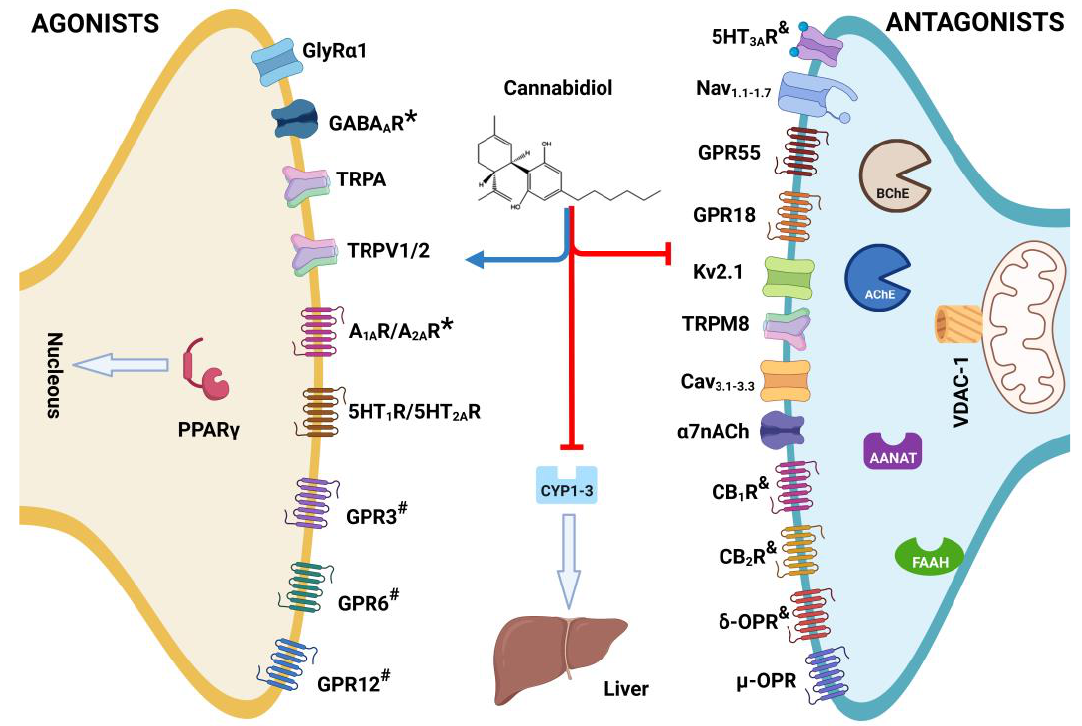
Figure 3. Structure of cannabidiol (CBD) and its role such as agonist or * = positive allosteric modulator (PAM), antagonist, # = inverse agonist, and & = negative allosteric modulator (NAM) on multi-target receptors and enzymes associates with developed of diseases in vivo. Created with BioRender.com. Table 2. CBD such as an agonist or PAM of receptors in the nervous system.